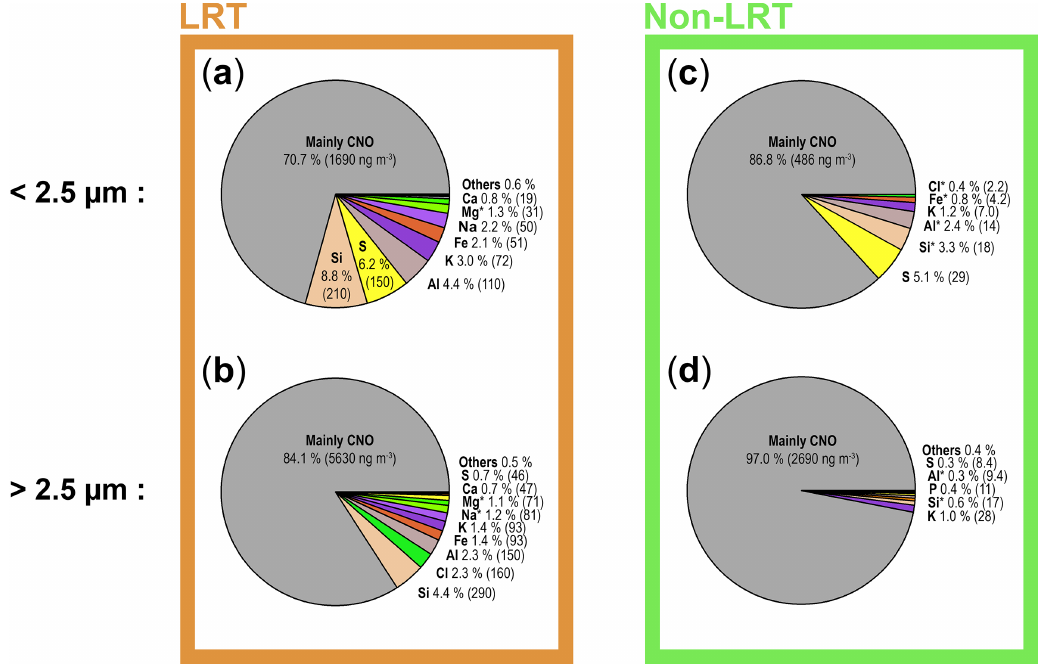
Figure 14. Mean relative mass fractions (in percent) and elemental mass concentrations (in ngm − 3 , in parenthesis) of aerosol particles in the size fractions > 2.5 and < 2.5µm for LRT episodes vs. periods without LRT influence (called non-LRT here). The sampling periods of the 5LRT filters and the 4 non-LRT filters are specified in Sect. 2.4 and plotted in Fig. S10. The average elemental fractions are quantified relative to the average deposited mass on the LRT vs. non-LRT filters, respectively. The EDXRF analysis allows to quantify the masses of elements with atomic numbers larger 10 (i.e., starting with Na). Accordingly, the lighter elements in the periods 1 and 2 of the periodic table of the elements account for the remaining mass. The elements C, N, and O represent the predominant contributors here. The results visualized here are provided in detail in the corresponding Table S3. If element are marked with ∗ , some data point were excluded from the analysis since they were below the detection limit according to Arana et al. (2014) (see also Sect.